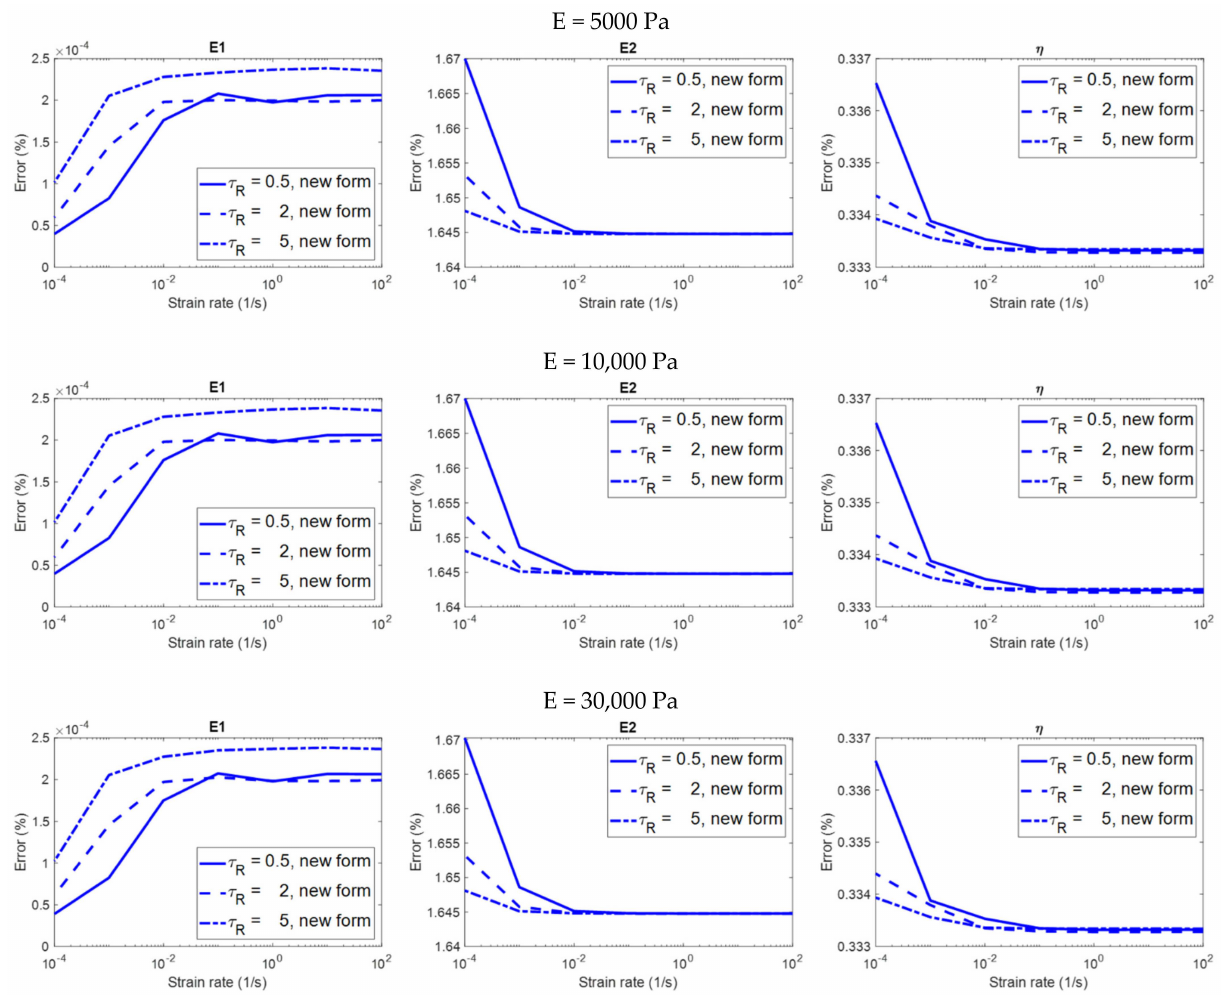
Figure 7. The relationship between the strain rate and the error in the evaluation of the viscoelastic properties on different material models in the stress relaxation simulation, analyzed using the newly − introduced constitutive equation derived with finite loading